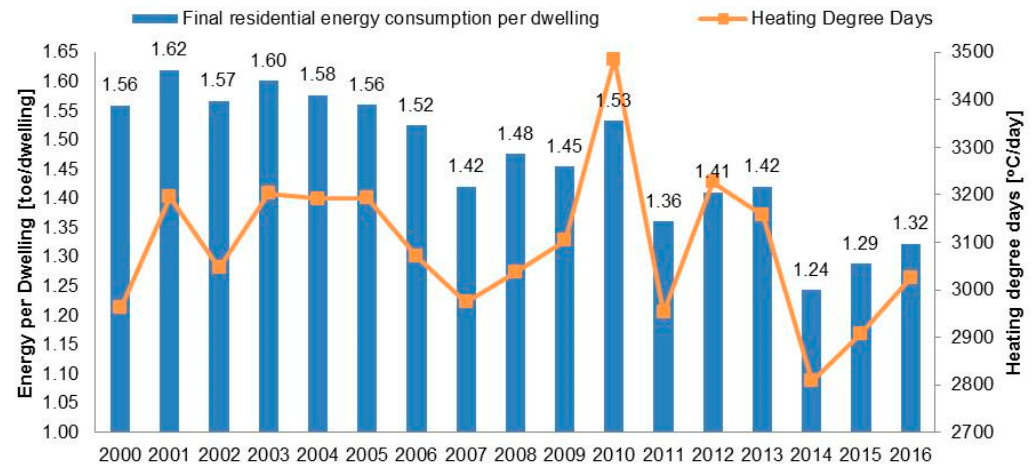
Figure 13. Final residential energy consumption per dwelling and heating degree days in the EU-28, 2005–2016. Source: Eurostat, Odyssee.